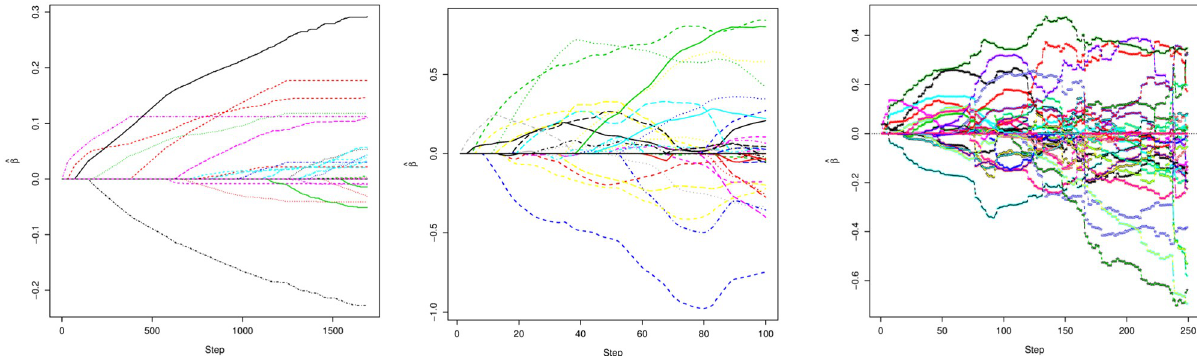
Fig 7. Coefficient paths for each modeling method for the MoBa dataset. A: Coefficient path from NB GMIFS. B: Coefficient path from glmnet where the x-axis indicates the sequence number of λ . C: Coefficient path from glmpath .